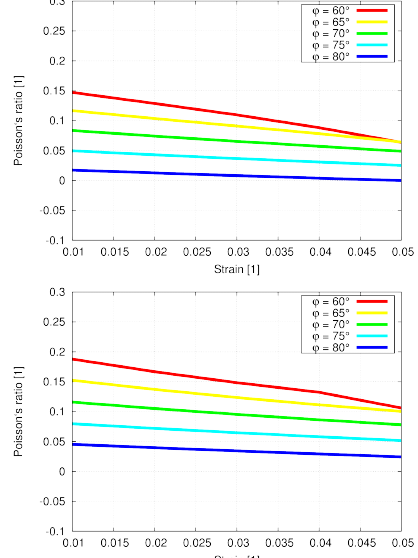
Figure 6. The Poisson’s ratio function (strain de- pendent Poisson’s ratio) of RVE with respect to the size of re-entrant angle in first loading mode (top) and second loading mode (bottom).